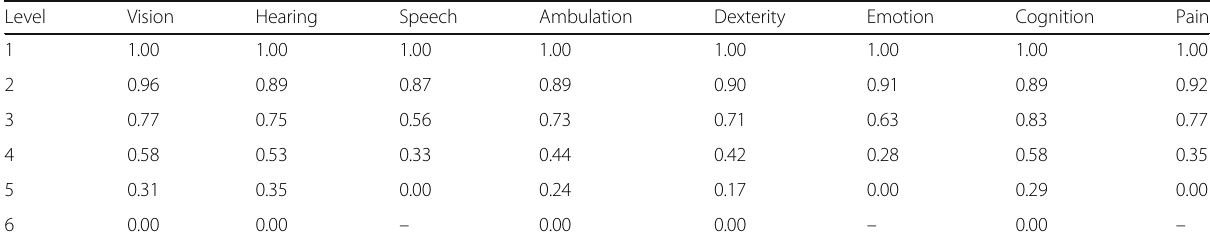
Table 3 Single-attribute utility function for Japanese HUI3 Level Vision